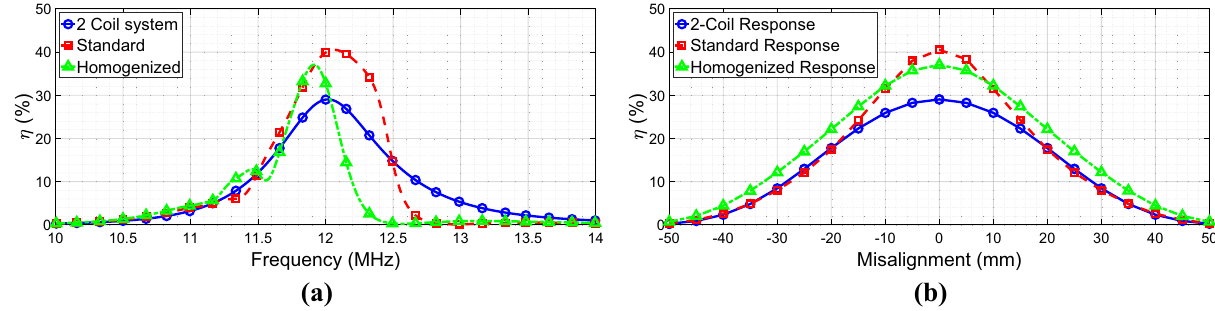
Figure 8. ( a ) Simulated efficiency plots of three configurations: 2-coil system (blue full line), standard metasurface (red dashed line), and homogenizing metasurface (green dashed-dotted line). ( b ) Efficiency versus misalignment: the homogenizing metasurface (green line) can preserve high efficiency values even under misaligned conditions, unlike the standard metasurface (red line) and the 2-coil system (blue line).